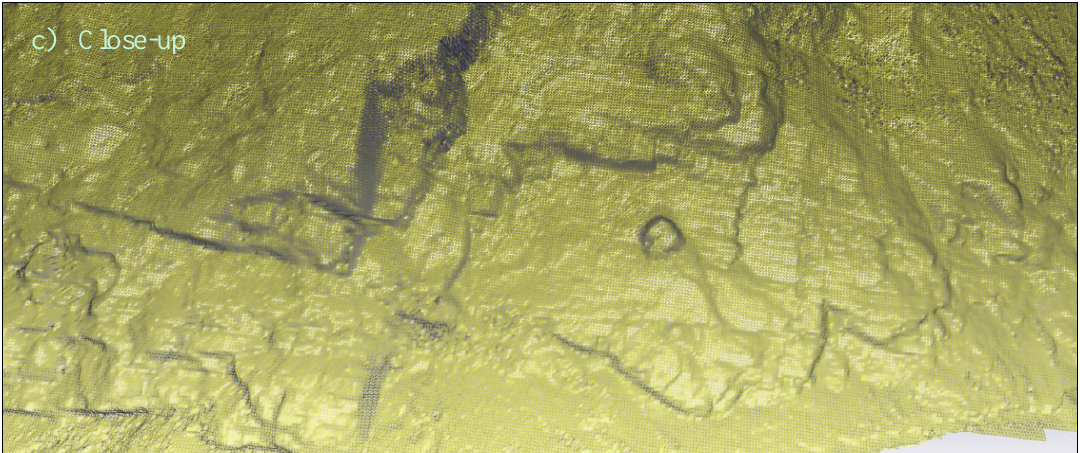
Figure 13. Sample results of surface modeling (0.05 m resolution) from the 2014 survey of the exposed rock at Site B with holes filled for the ( a ) west and ( b ) east portions of the site; ( c ) Close-up wireframe model of a section for detail.